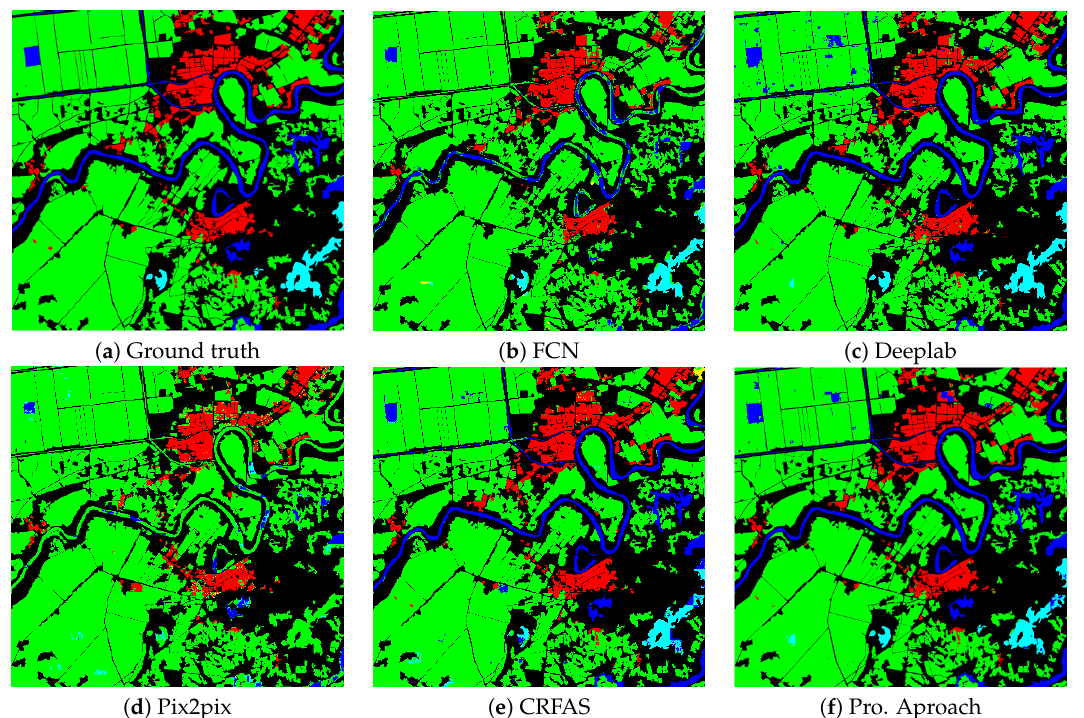
Figure 11. Segmentation results of GID-image2. ( a ) The ground truth; ( b – d ) the results by FCN, Deeplab, and Pix2pix, respectively; ( e , f ) the results by CRFAS and the proposed approach.